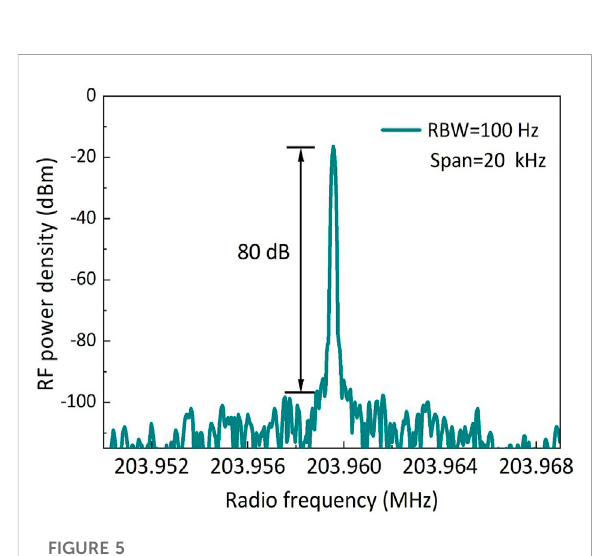
FIGURE 5 Fundamental RF spectrum measured at a resolution bandwidth of 100 Hz showing a signal-to-noise ratio of 80